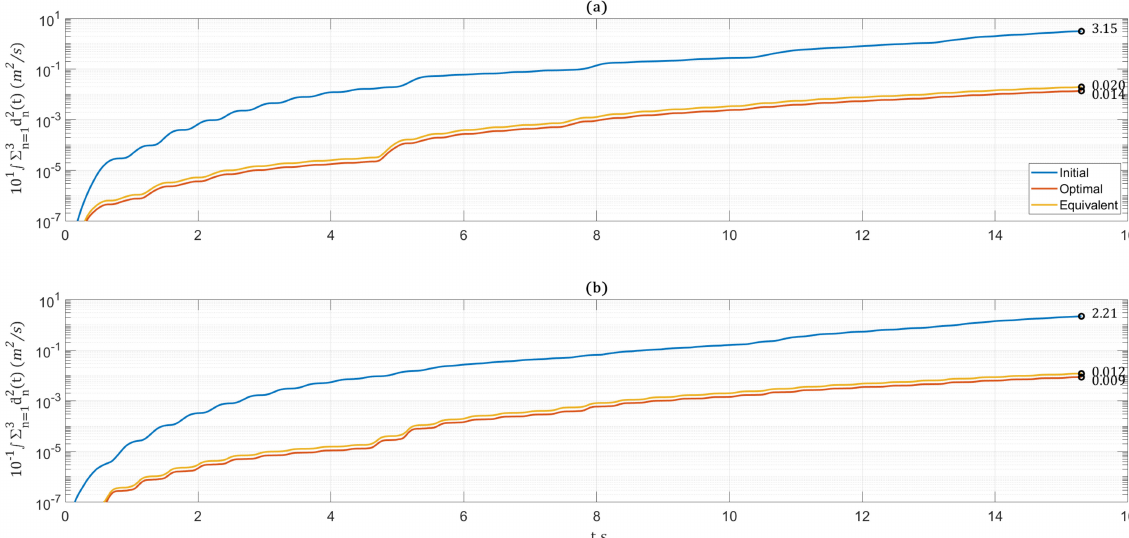
Figure 14. Fixed-point iterative process for the 15-story rigid frame system.